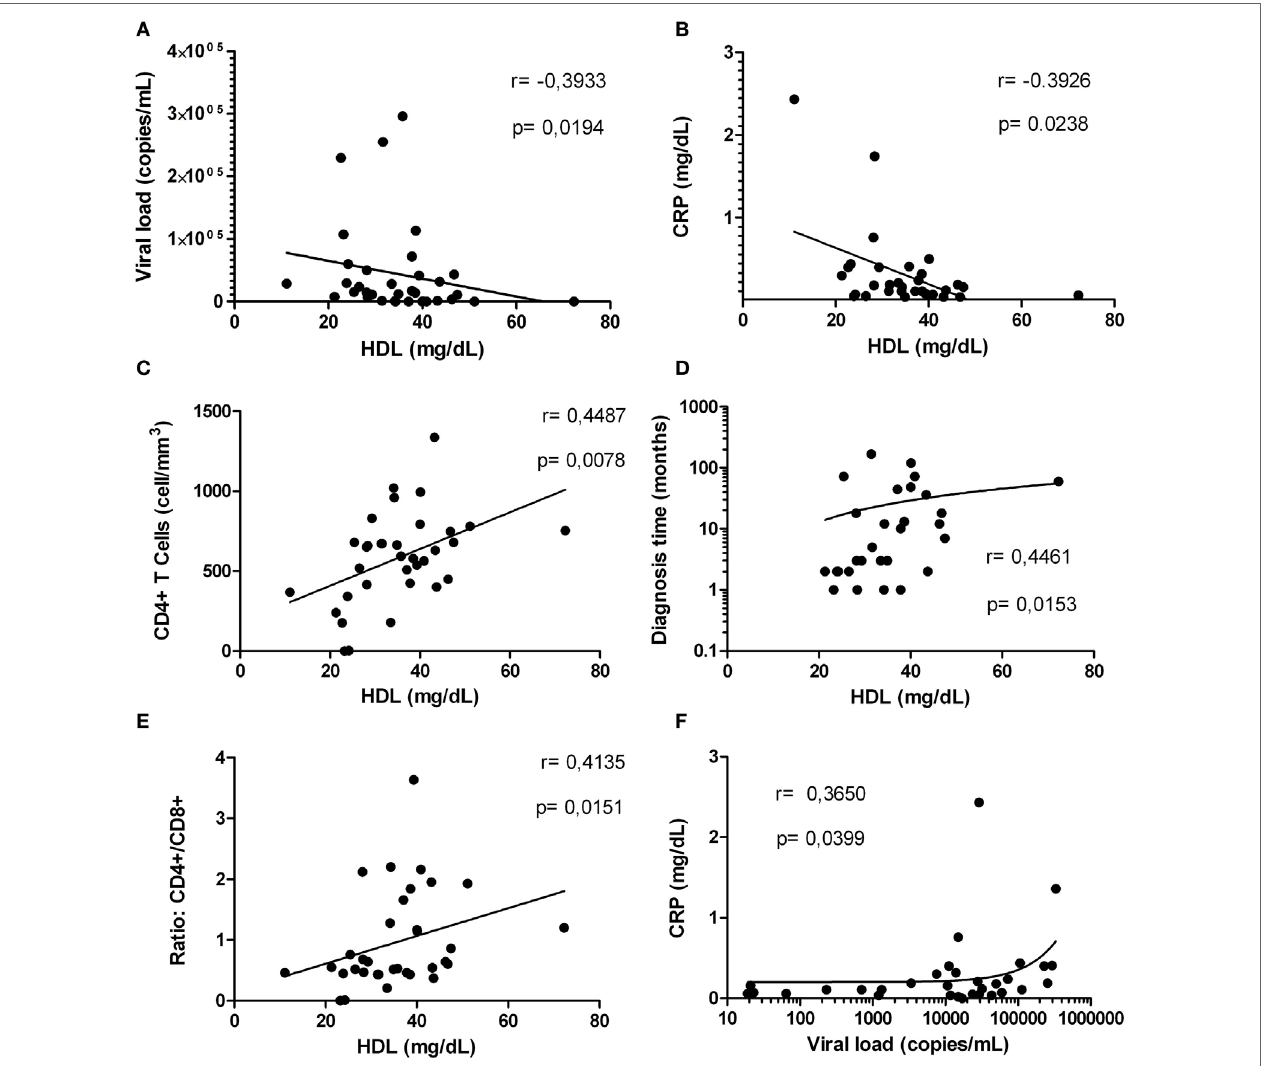
FigUre 7 | Correlations between high-density lipoprotein (HDL) levels with factors associated with human immunodeficiency virus type 1 progression. Correlation analysis between HDL levels and: viral load (a) , C-reactive protein (CRP) (b) , CD4 + T-cells (c) , diagnosis time (D) , and ratio CD4 + /CD8 + (e) . In addition, correlation between viral load and CRP is presented (F) . The correlation analyses were performed using a Spearman test. The r and p values are indicated in each figure. A p value lower than 0.05 was considered as significant